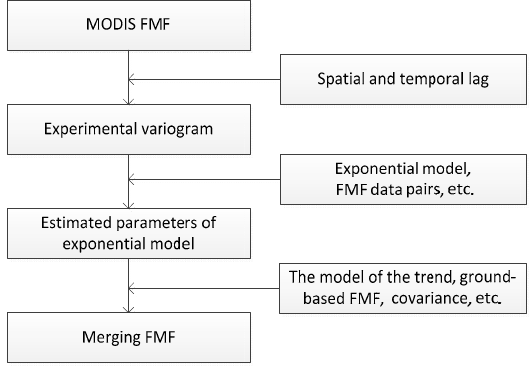
Figure 1. The flowchart of the fusion method applied to merging MODIS FMF and ground-based FMF.